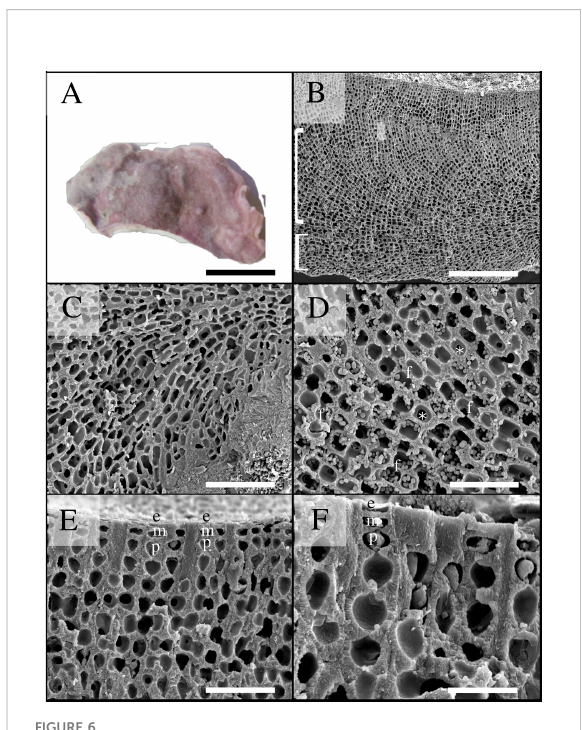
FIGURE 6 Scanning electron microscopy images of Phymatolithon abuqirensis voucher TS 759 (LAF 7723). (A) Habit view of thallus, scale bar = 1 cm. (B) Section view showing monomerous thallus construction with hypothallial cells grown parallel to substratum (bottom bracket) and perithallial fi laments arching upward (top bracket), scale bar = 200 µm. (C) Magni fi ed view of hypothallium over substratum, scale bar = 100 µm. (D) Magni fi ed view of perithallium with adjacent perithallial cells linked by cell fusions in the x-axis (f) and z- axis (*), scale bar = 20 µm. (E) Section showing domed epithelial cells (e), meristematic cells (m), and teardrop-shaped perithallial cells (p), scale bar = 30 µm. (F) Magni fi ed view showing surface cells, emphasizing the domed epithelial cells (e), meristematic cells (m), and teardrop-shaped perithallial cells (p), scale bar = 20